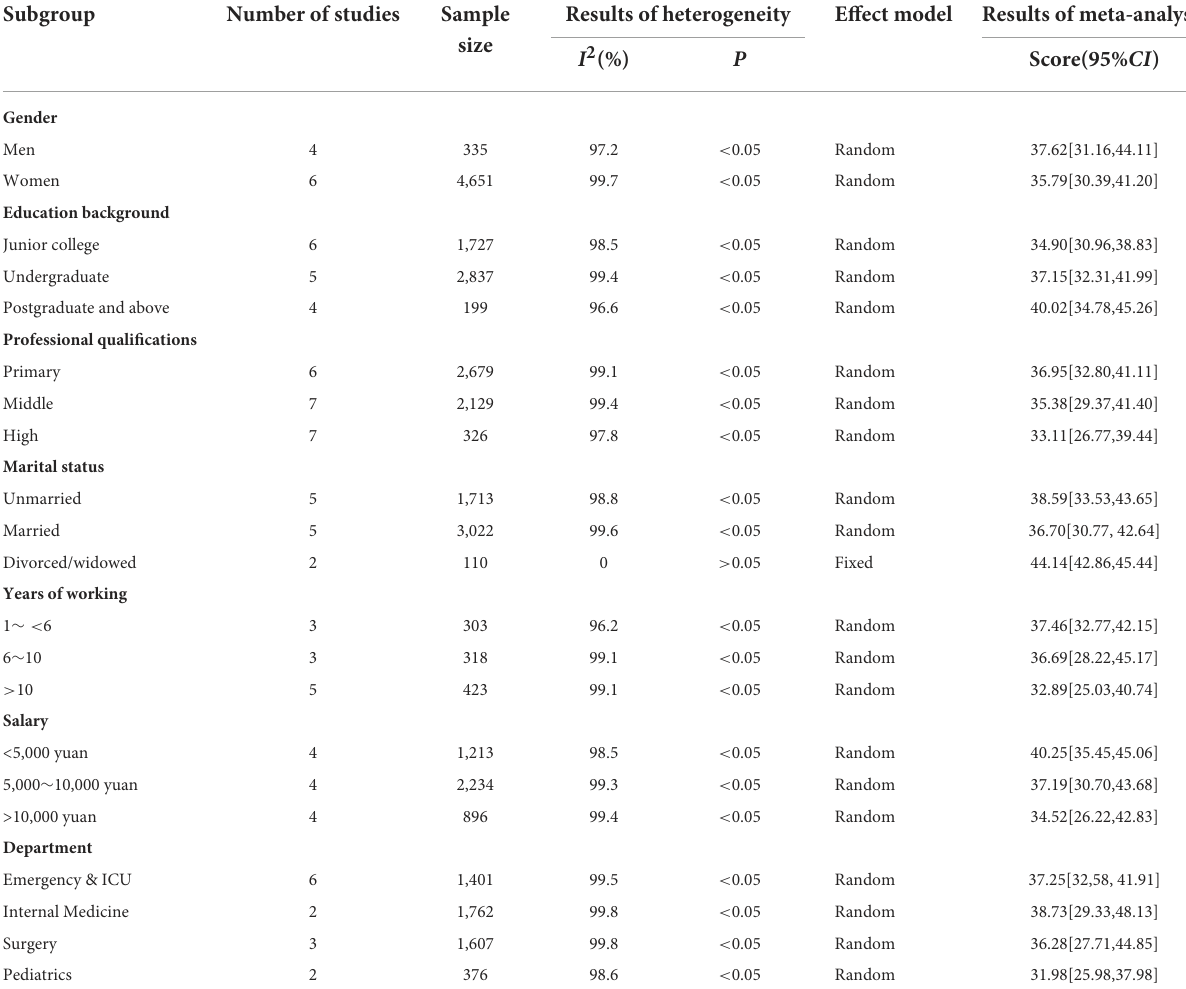
TABLE 2 Subgroup analyses of the PDF. Subgroup Number of studies Sample